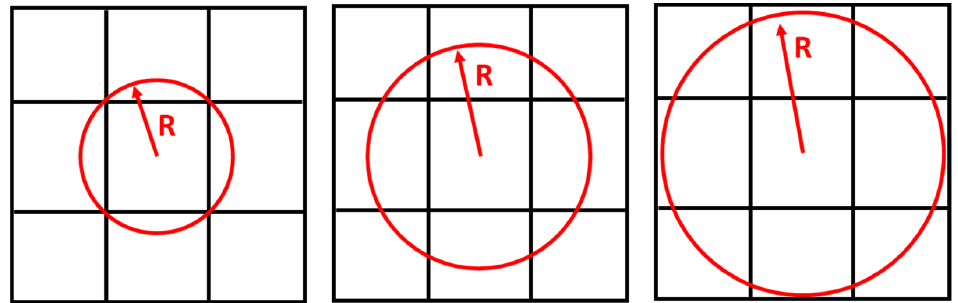
Figure 3. The radius filter to obtain a better objective.